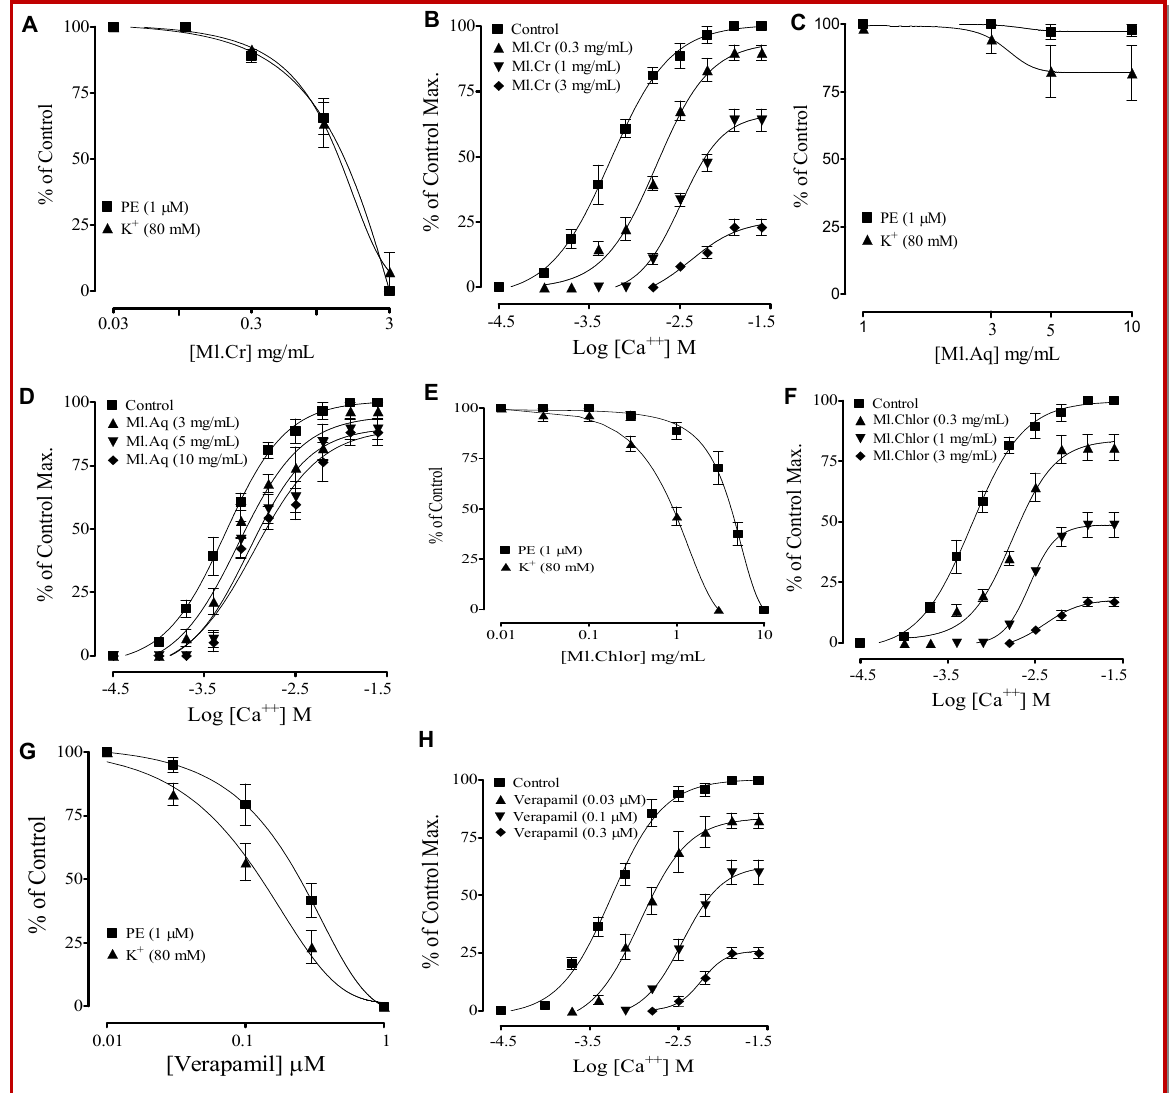
Figure 2: Concentration-dependent inhibitory effect against phenylephrine (PE) and high K + (80 mM)-induced vasoconstriction by the (A) crude extract of M. alongifolia (Ml.Cr); its (C) aqueous (Ml.Aq) and (E) chloroform (Ml.Chlor) fractions and (G) vera- pamil, in isolated rabbit aorta preparations. B, D, F and H show, respectively, the effect of Ml.Cr, Ml.Aq, Ml.Chlor and vera- pamil on the Ca ++ concentration-response curves, constructed in Ca ++ -free medium. Values shown are mean + SEM of 6 deter-